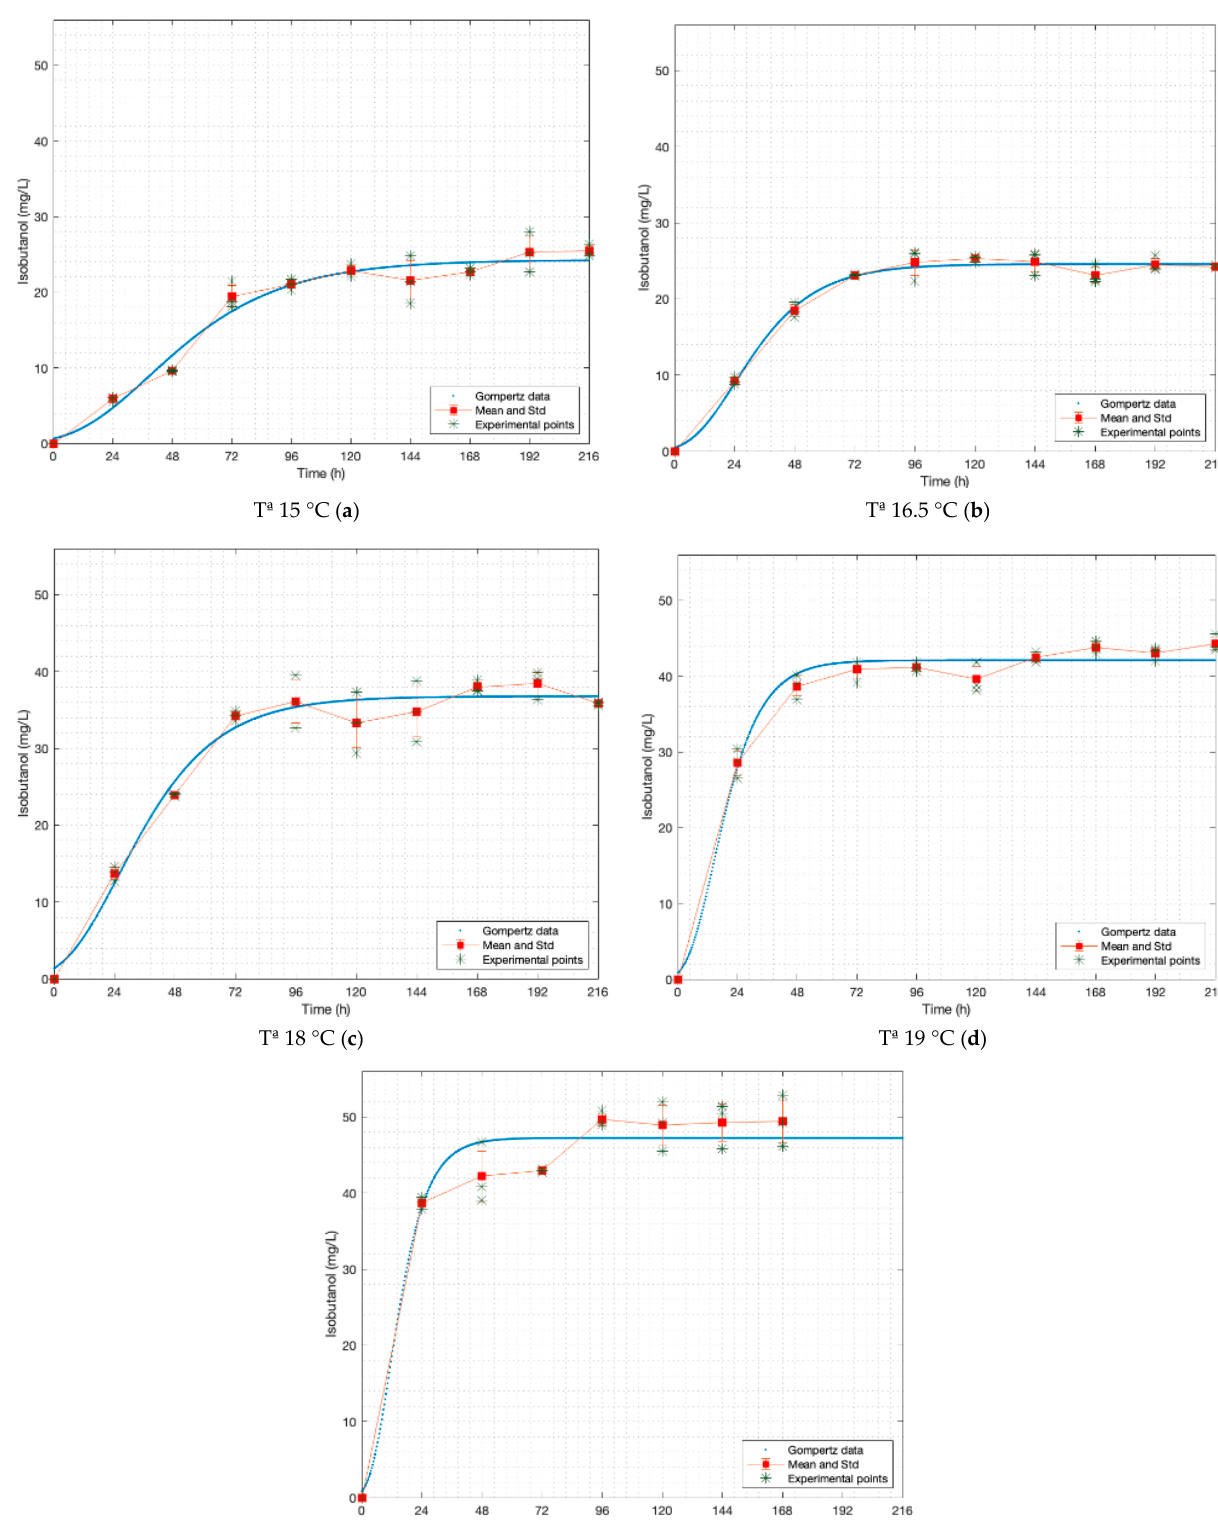
Figure 2. Gompertz graphs of predicted values for isobutanol. ( a ) Dataset 15 ◦ C; ( b ) dataset 16.5 ◦ C; ( c ) dataset 18 ◦ C; ( d ) dataset 19 ◦ C; ( e ) dataset 21 ◦ C. Blue lines represent the Gompertz function. Asterisk for experimental raw data. Squares and red lines represent the means and standard deviations.